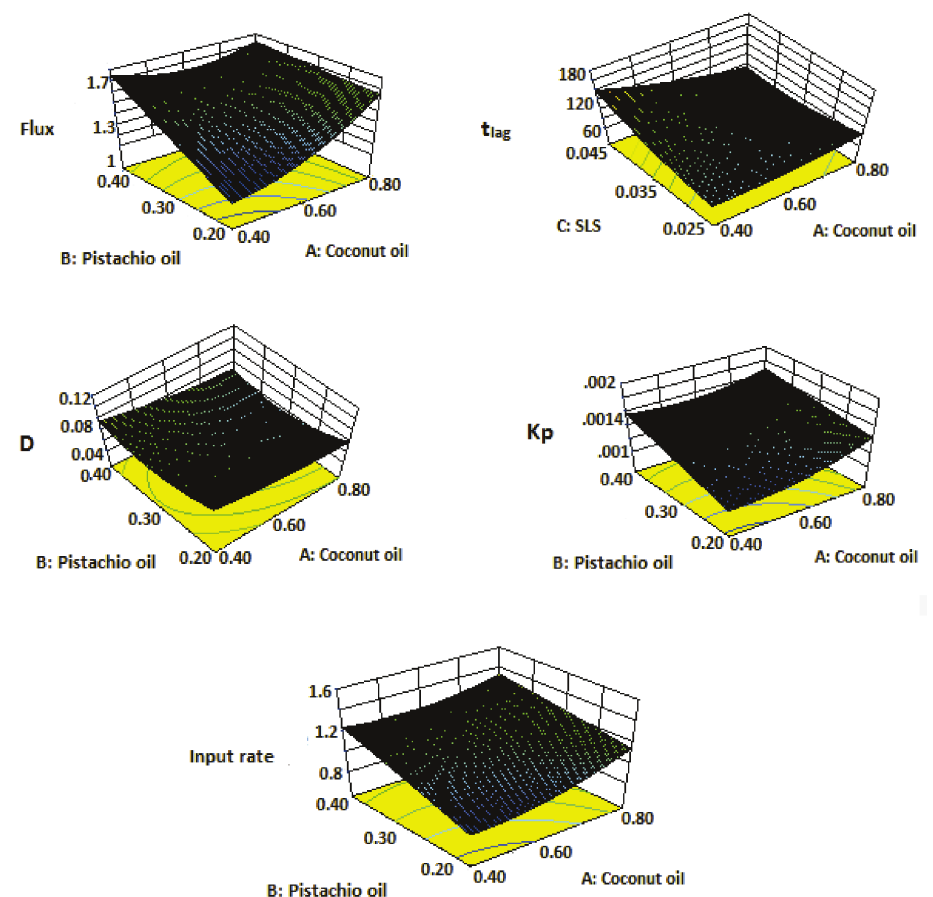
Figure 2 - Three Dimensional (3D) Plots of all Five